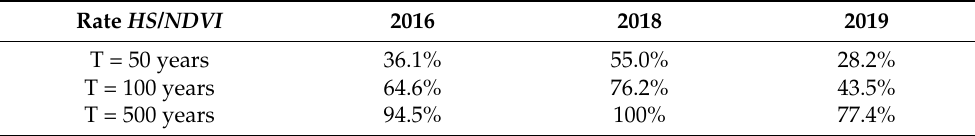
Table 3. Coverage ratio of the NDVI analysis for different return periods for the last three DANAs of 2016, 2018, and 2019 and the resulting simulation from national regulations with the current Horton–Strahler theoretical model of the watershed.